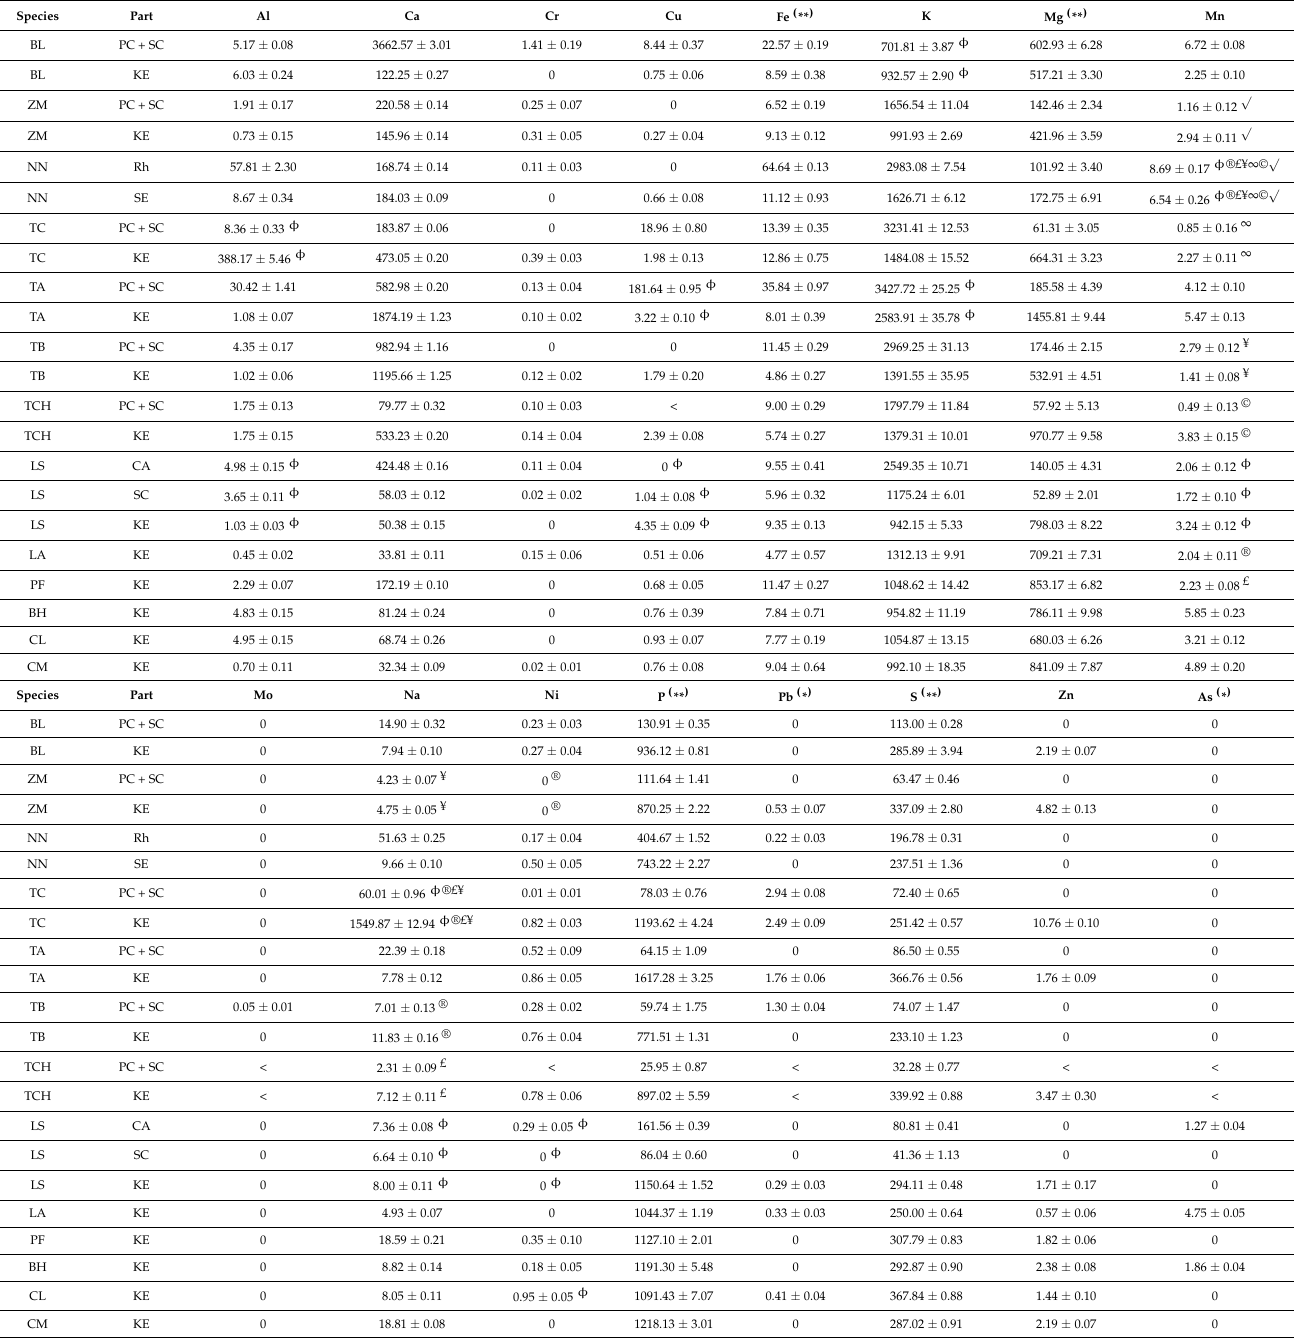
Table 3. Mineral content of herbal fruit, mg/100